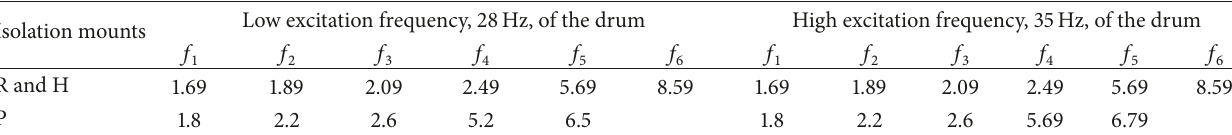
Table 7: The resonance frequencies of three cab’s isolation mounts.